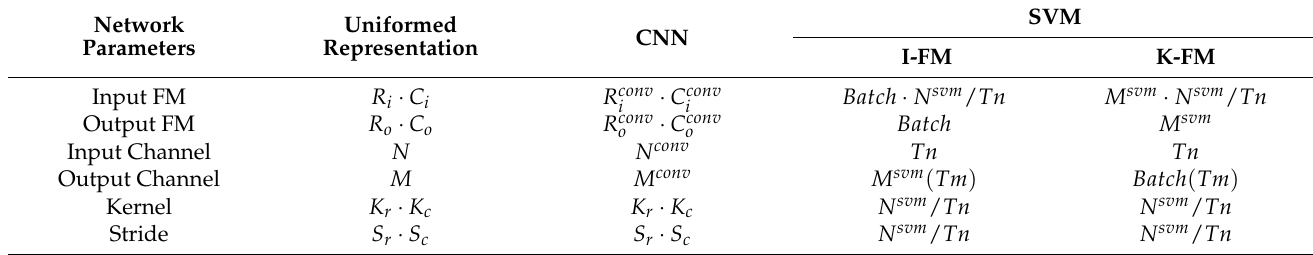
Table 1. Uniformed representation parameters for CNN and